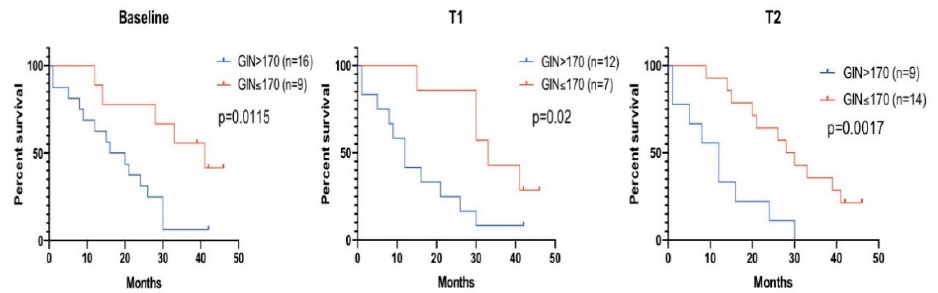
Figure 3. Overall survival and GIN detection at different time points. The overall survival of patients with plasma GIN values above and below the pre ‐ established threshold (170) at 3 different time points. Left: Baseline, middle: T1 (average 1 week post ‐ treatment) and right: T2 (average 2 weeks post ‐ treatment).